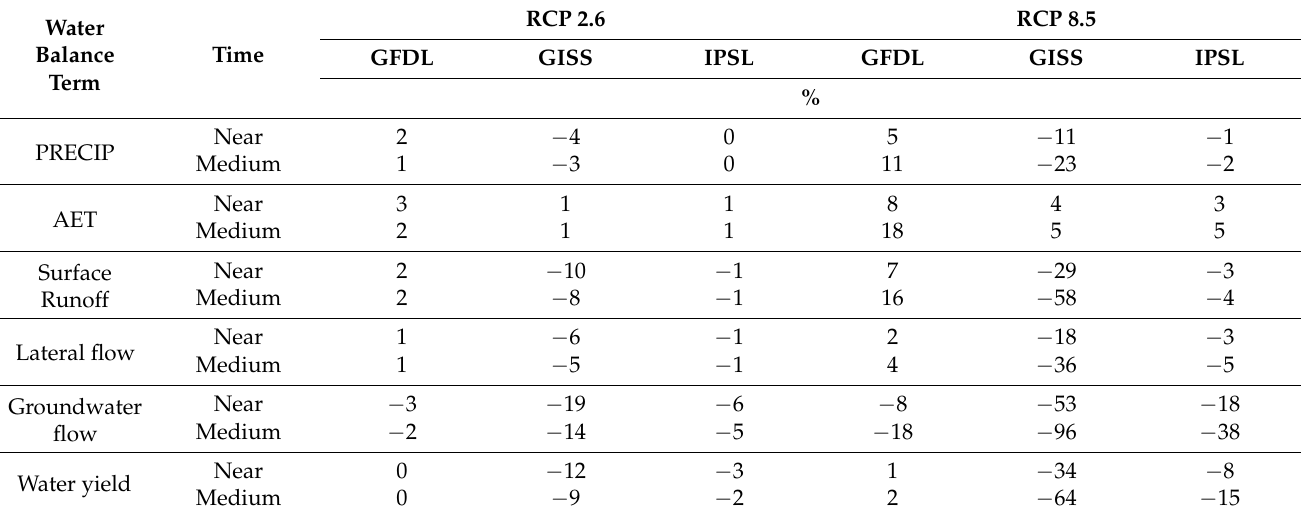
Table 6. Changes in basin-wide water balance terms (%) for near (2020–2040) and